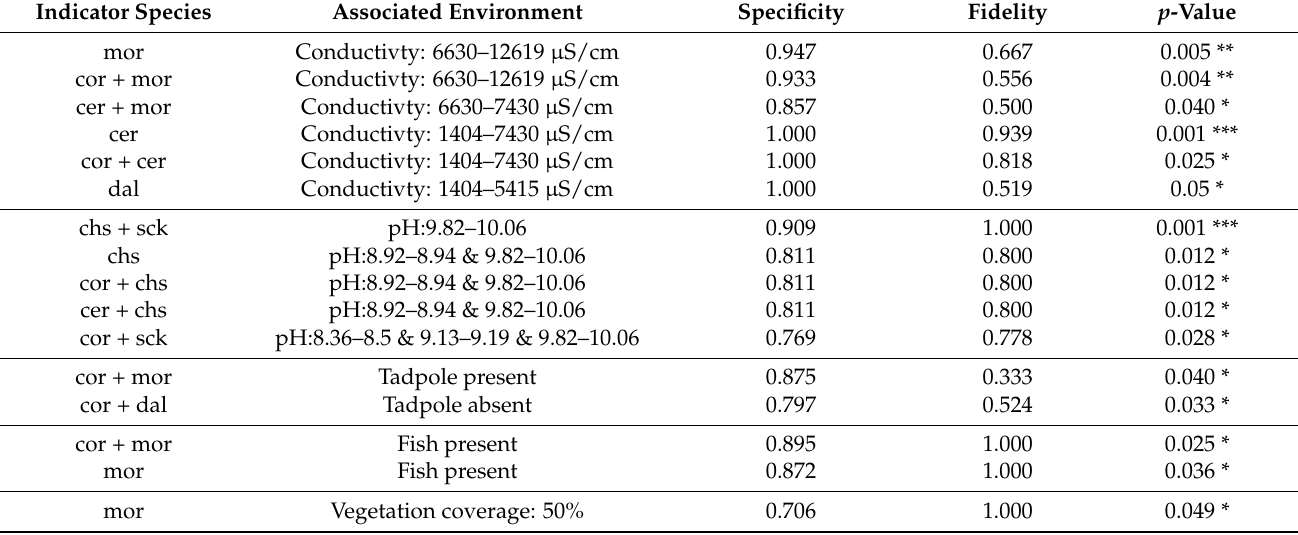
Table 3. Selected indicators (species and species combinations) and associated environmental variables. Significance codes: